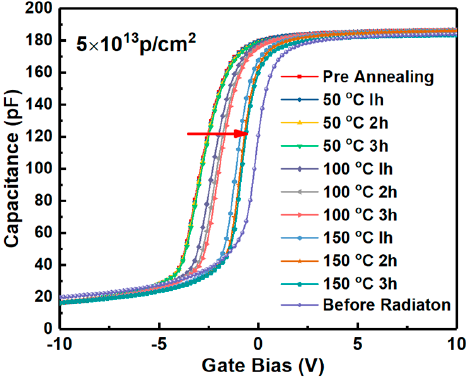
Figure 15. Energy distributions of interface states densities of the samples irradiated by proton doses obtained by Terman’s method.